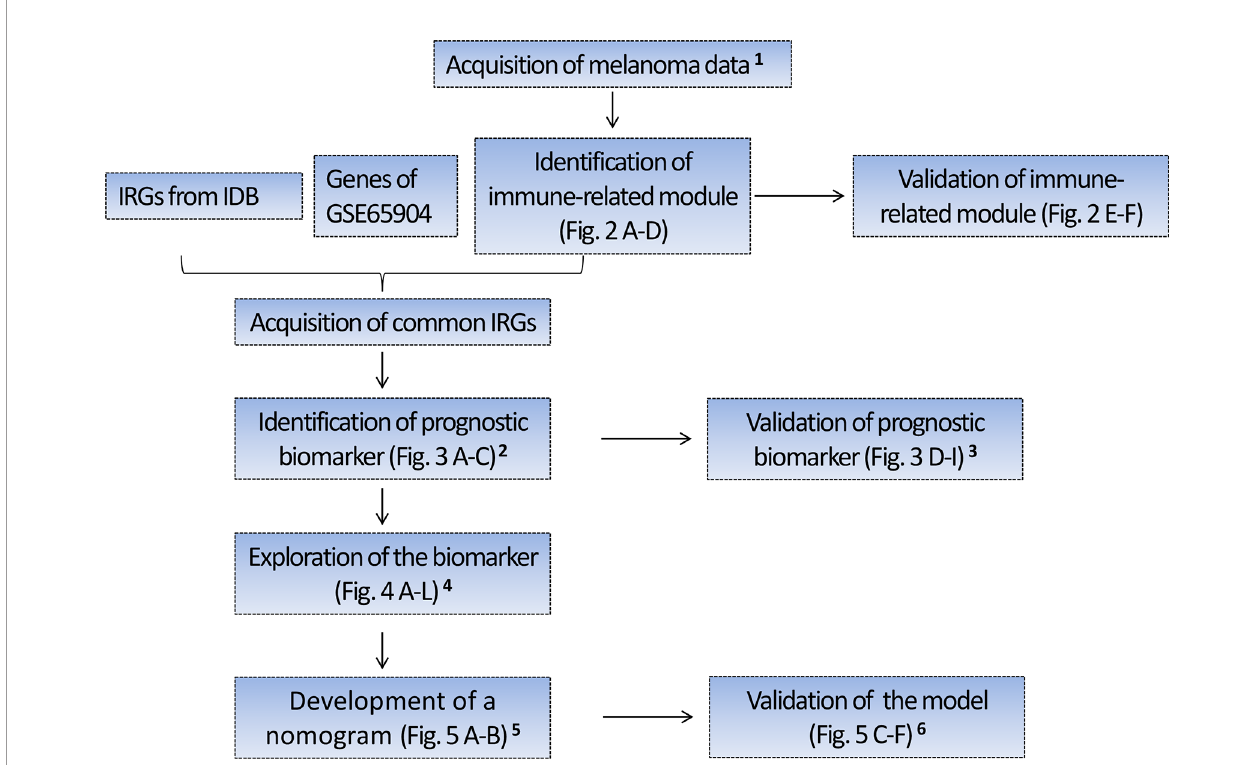
FIGURE 1 | Flow chart depicting the protocol. 1 Four hundred forty-nine melanoma cases with RNA sequencing (RNA-seq) data from TCGA were randomly divided into the training set I (n = 224) and validation set I (n = 225), 210 melanoma cases with RNA-seq data from Lund cohort of Lund University (available in GSE65904) were used as an external test set. The above three sets were used to identify and validate a prognostic gene biomarker. 2 Based on the training set I, we identi fi ed a four-gene biomarker from 56 IRGs using the univariate Cox regression analysis and LASSO regression analysis. 3 The predictive performance of the four-gene biomarker was validated in the training set I, validation set I, and an external test set (GSE65904). 4 Exploration of the biomarker includes the association of the four- gene biomarker with the patient ’ s survival, immune score, clinical stage, tissue pathological type, tumor-in fi ltrating immune cells, and KEGG pathway. 5 Four hundred seventy melanoma cases with clinical data were obtained from TCGA and 91 cases with missing clinical data were excluded from the study. Three hundred seventy- nine cases with complete clinical data were subsequently randomly assigned to the training group II (n = 189) and validation group II (n = 190), which were used to develop and validate the nomogram predictive model. In developing the nomogram, the four-gene biomarker and clinical characteristics were used as variables. 6 The predictive power of nomogram combining the four-gene biomarker and clinical characteristics was assessed in the training set II and validation set II. IRGs, immune-related genes; IDB, the InnateDB